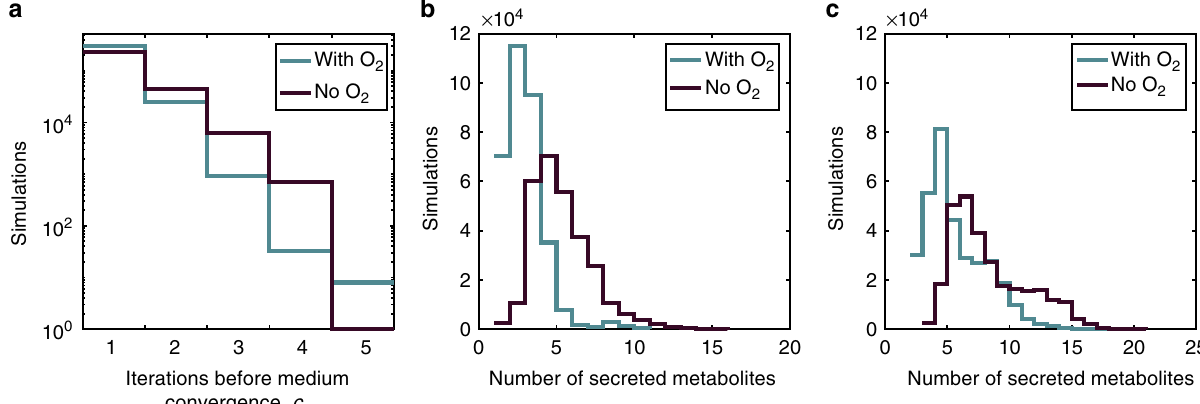
Fig. 2 Analysis of costlessly secreted metabolites in pairwise simulations. Only simulations that led to growth of at least one organism are shown. a Distribution of number of expansions until fi nal medium expansion iteration. Ninety-two percent of simulations reached a steady medium composition after only one iteration with oxygen, compared to 82% of simulations without oxygen. b Distribution of the number of metabolites secreted into the medium by one or both organisms in a pair after one iteration of FBA ( c = 1). These distributions were unimodal for both conditions, centered between two and three metabolites with oxygen and around fi ve metabolites without oxygen. After this fi rst iteration, the maximum number of secreted metabolites was 11 with oxygen and 16 without oxygen. In the anoxic simulations, the central carbon metabolites most commonly secreted after the fi rst iteration were fermentation byproducts such as acetate, formate, succinate, and ethanol. These metabolites were secreted in 87.5%, 74.5%, 25.7%, and 20.2% of growth-yielding simulations respectively. With oxygen, the most commonly secreted central carbon metabolites after the fi rst iteration were formate and acetate, secreted in 46.8% and 18.3% of growth-yielding simulations, respectively. c Distribution of the number of metabolites secreted by one or both organisms after the last iteration of FBA ( c = c S ). The last iteration is de fi ned as the iteration in which no additional metabolites were released into the medium. The total number of secreted metabolites followed similar distributions with a maximum at 18 and 21 metabolites for oxic and anoxic conditions, respectively. Despite the large variability in number of expansions and number of secreted metabolites, we observe a poor correlation between these distributions, indicating that a simulation resulting in a high number of expansions does not necessarily result in a high number of metabolites being secreted (Supplementary Fig. 3) (Fig. 2b), as well as a shift in the quantity of metabolites secreted between the fi rst and last iteration of each simulation (Fig. 2c). This latter effect re fl ects organisms taking up metabolites secreted by themselves or their partner, and secreting different metabolites as a